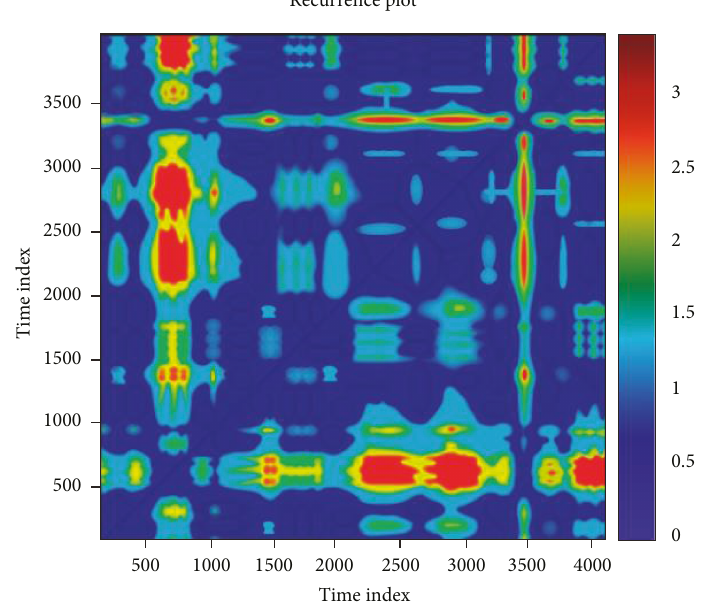
Figure 9: Graphic recurrence of the wind series.